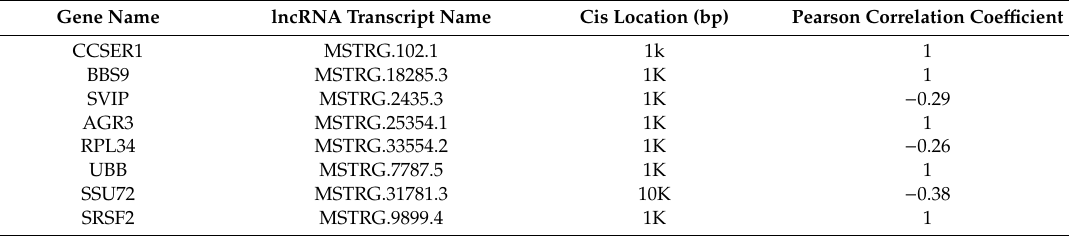
Table 2. Di ff erentially expressed lncRNA-gene pairs between high and low sperm motility groups.